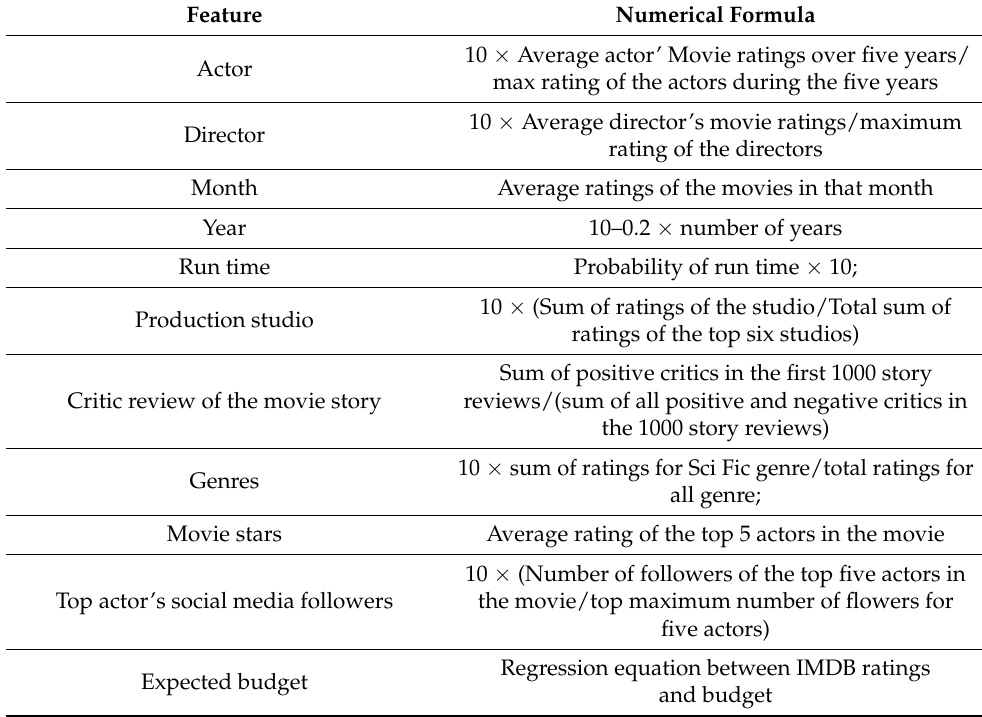
Table 5. Feature numerical